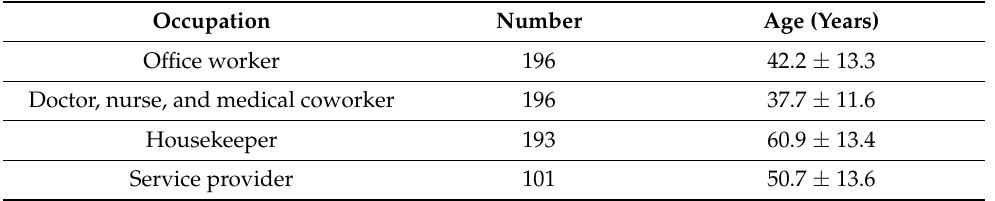
Table 2. Occupation of 1211 asymptomatic